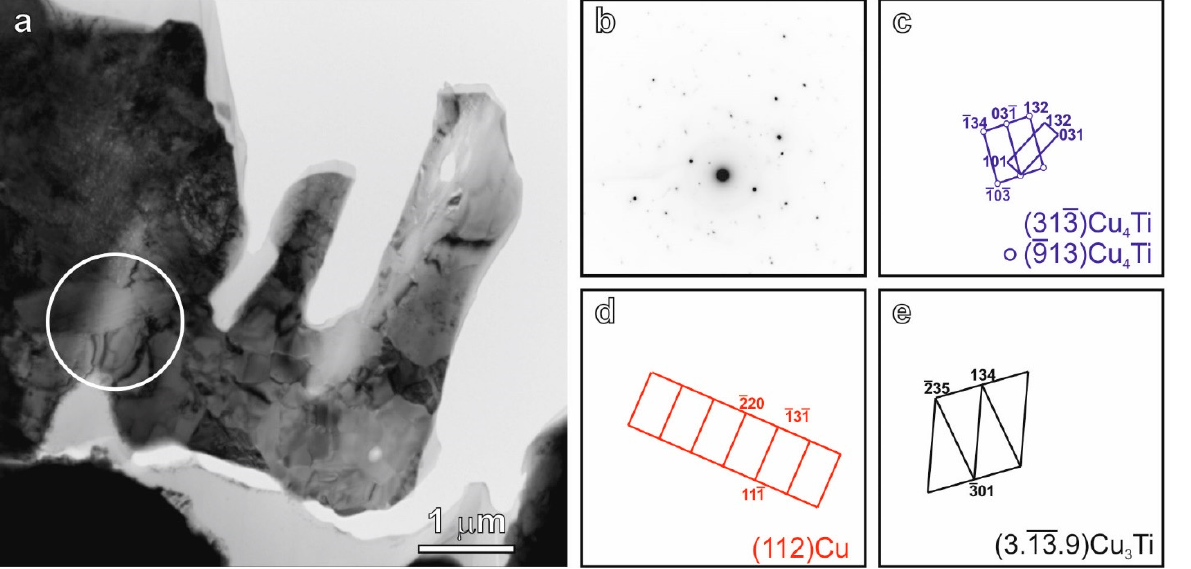
Figure 5. TEM images of the surface layer of the copper alloy modified by titanium ions (12 min): general views of the cross section of the modified surface ( a ), microdiffraction patterns and schemes of their indexing ( b – e ).